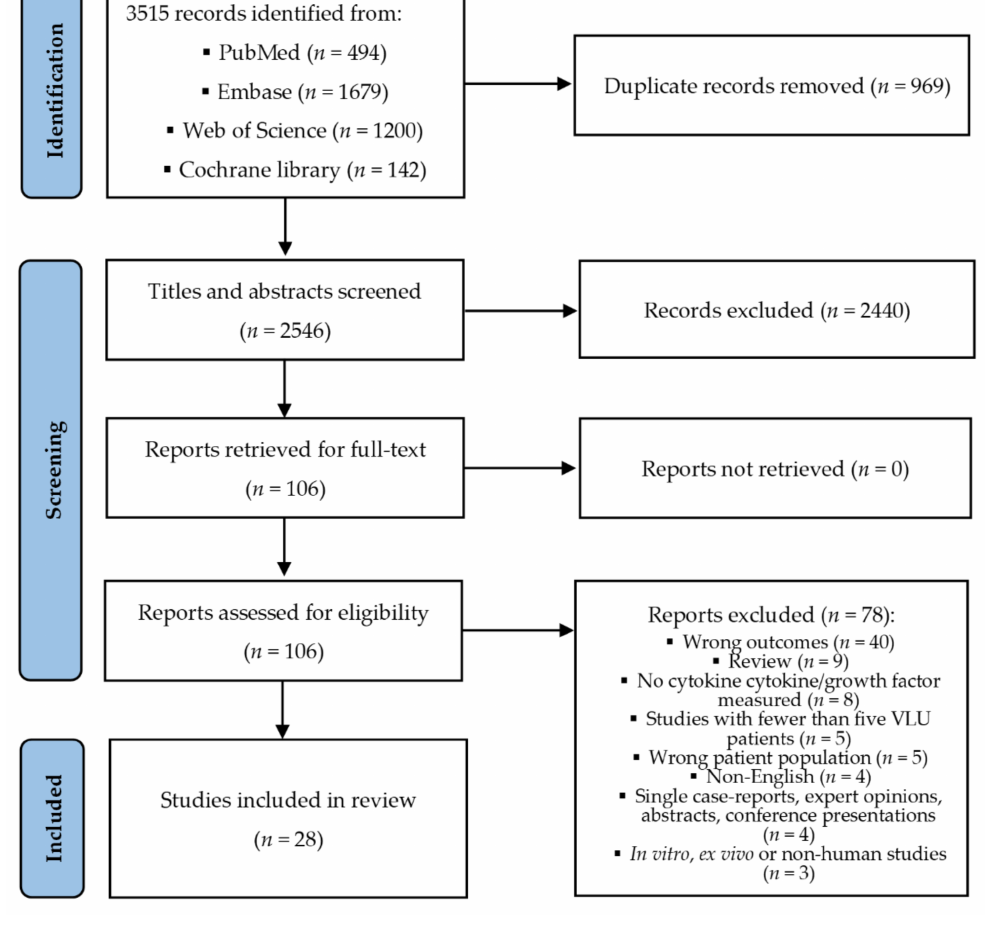
Figure 1. PRISMA flow diagram